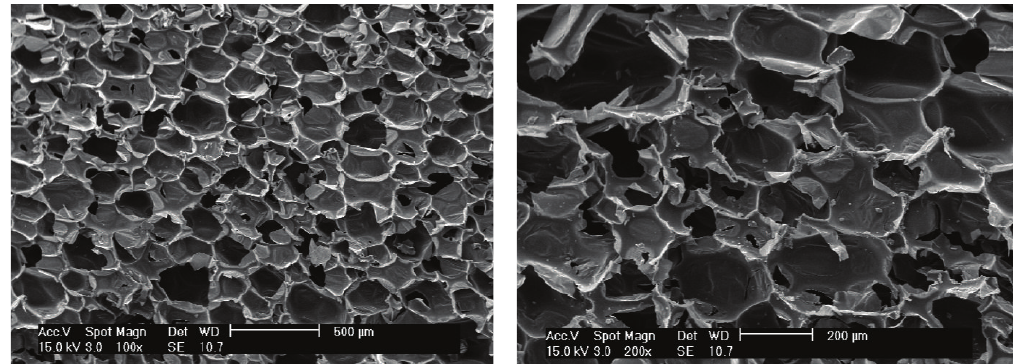
Figure 1: Microstructure section of the open cell polyurethane foam (magnified 500 and 200 times).